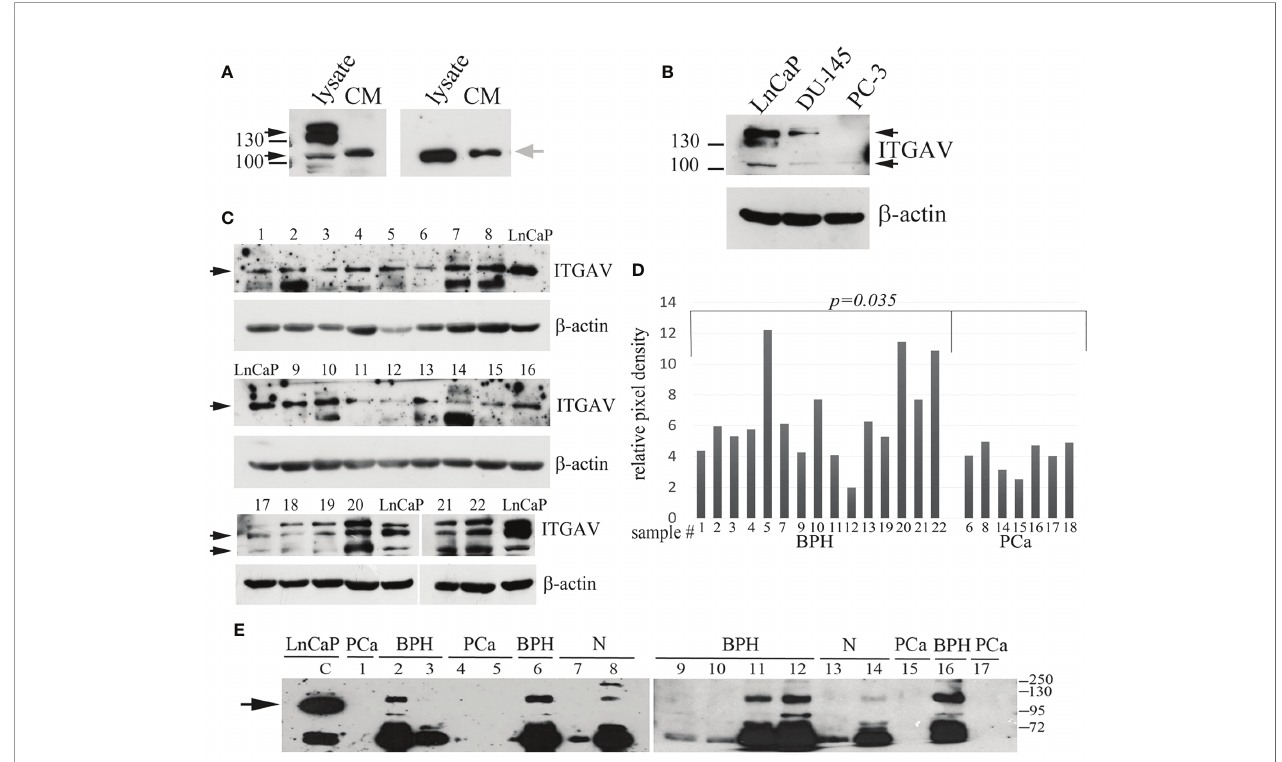
FIGURE 1 | Quantitation of Integrin alpha V (ITGAV) level by Western blot. (A) LnCap cell lysates and the conditioned media (CM) produced by LnCaP cells were assayed for ITGAV expression using polyclonal antibodies purchased from Cloud Clone Corp. (A, left panel) and MyBioSource (A, right panel). MW markers of 100 and 130 kDa are shown. Black arrows show ITGAV immunoreactive bands identi fi ed in the cell lysates, and grey arrow points on ITGAV found in the CM media. (B) Analysis of LnCaP, DU145, and PC3 cell lysates for ITGAV expression using indicated antibodies. b -actin serve as loading controls. Black arrows show the ITGAV-positive bands (about 116 kDa and double band 130 – 140 kDa), the position of the molecular weight (MW) markers (kDa) are shown on the left. (C) ITGAV expression in prostate tissue samples. Samples 1 – 16 were assayed with anti-ITGAV antibody from MyBioSource, and samples 17 – 22 were probed with anti-ITGAV antibody from Cloud Clone Corp. Arrows indicate the position of ITGAV immunoreactive bands. b -actin serve as loading controls. (D) Quantitation of ITGAV level obtained in C by densitometry analysis. The intensity of the ITGAV signal was normalized to the b -actin level in each sample. P-value was calculated by t-tests and represent the probability of no difference between ITGAV levels in BPH and PCa samples. (E) Urine was collected from patients with prostate cancer (PCa: lines 1, 4, 5, 15, 17) and controls (BPH: lines 2, 3, 6, 9 – 12, 16; age matched subjects (N): lines 7, 8, and 13, 14). The presence of prostate cancer (PCa) was con fi rmed